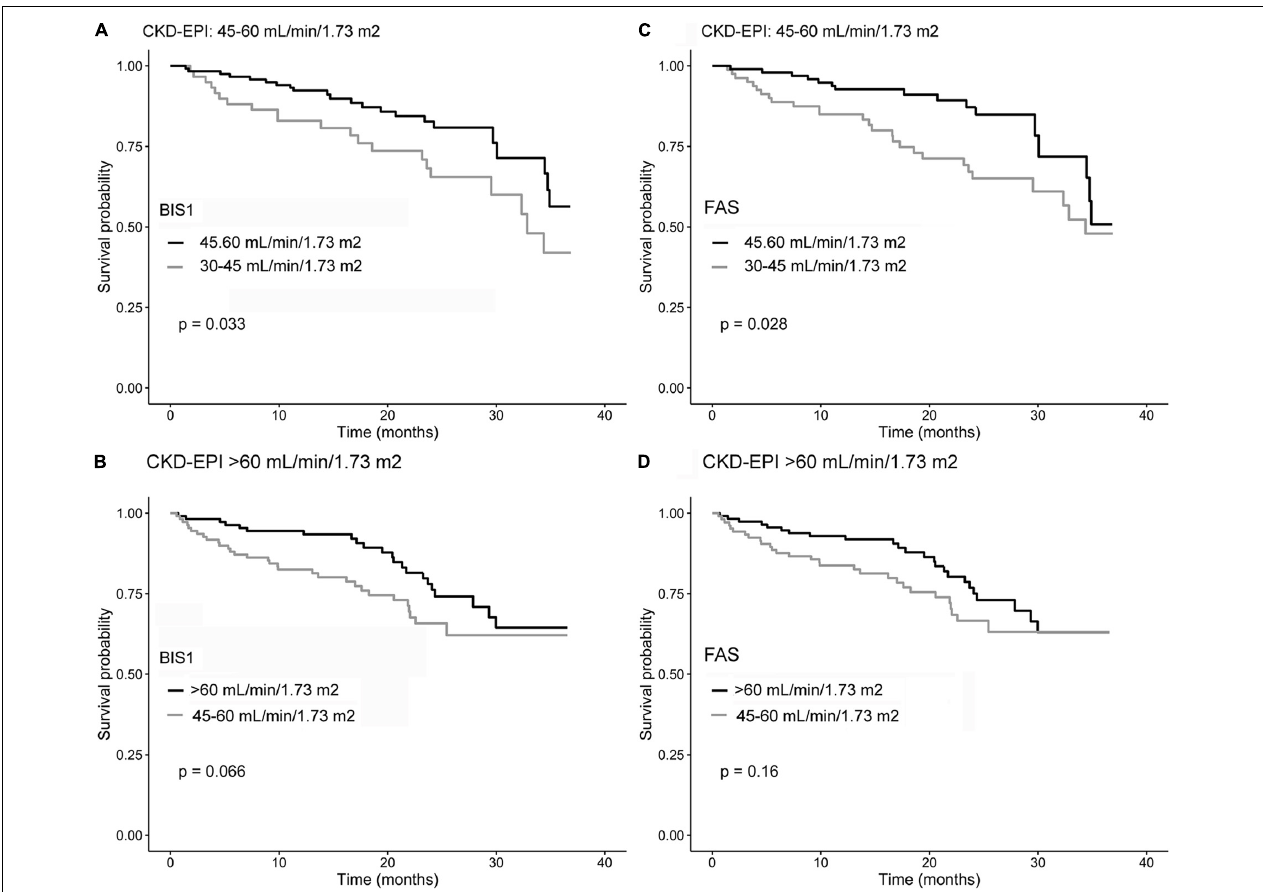
FIGURE 4 | Kaplan–Meier survival curves of NH residents reclassified by comparing CKD-EPI and BIS1 (A,B) and CKD-EPI and FAS (C,D) . Gray curves indicate reclassified residents, while black curves indicate residents not